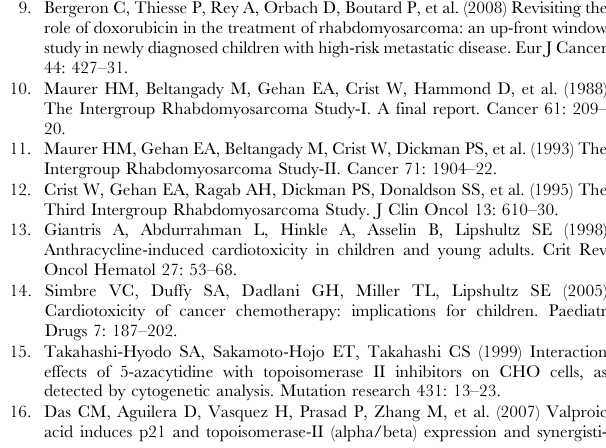
used to calculate the significance of changes in tumor regrowth 1.2 mg/kg DOX. The observation period after treatment end was and adjusted for tumor size differences at the onset of the